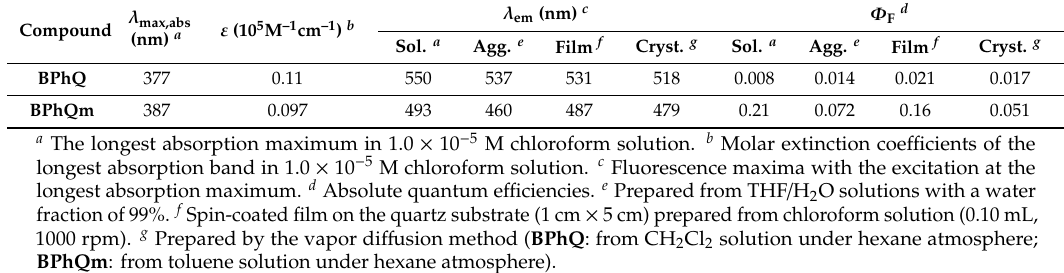
Table 1. Optical properties of the synthesized compounds.